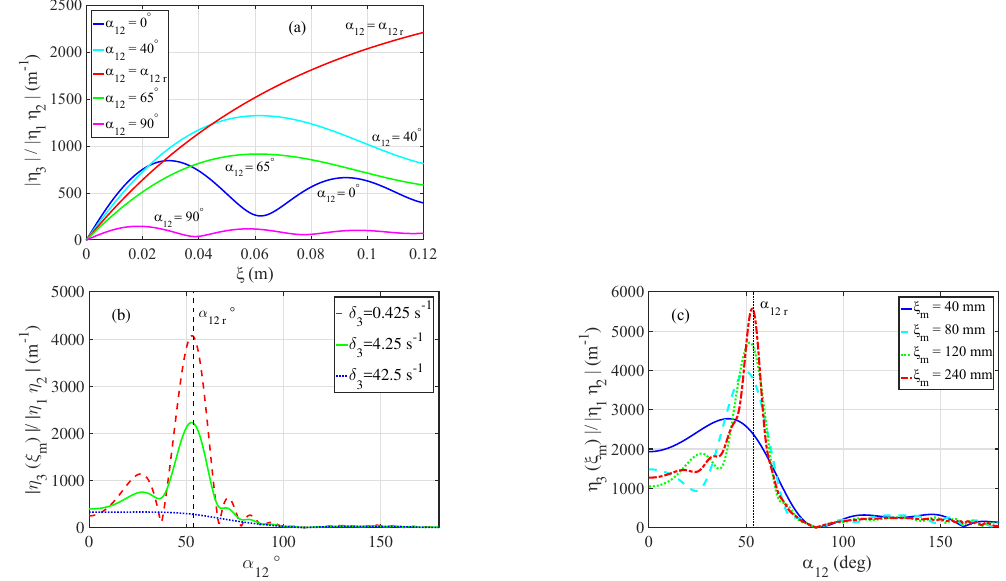
Figure 11. Prediction of the model of a forced three-wave interaction according to Cazaubiel et al. [42]. ( a ) Normalized amplitude | η 3 ( ξ ) / | η 1 η 2 | as a function of ξ , for various values of the angle α 12 between the two mother waves. ( b ) Normalized amplitude | η 3 ( ξ m ) | / | η 1 η 2 | evaluated in ξ m = 0.12m as a function of α 12 for various values of the dissipation rate ( δ 3 = 4.25s − 1 is the expected dissipation at f 3 = 33Hz in the experiments). The curve for negative values of α 12 is symmetric to the displayed one, due to the parity of the interaction coefficients with α 12 . ( c ) Amplitude of the daughter wave | η ( ξ m ) | (normalized by | η | ) as a function of α 3 1 η 2 12 for various values of the propagation distance ξ m for a dissipation rate δ 3 = 4.25s − 1 . (Reprinted with permission from Ref. [42] Copyright 2022 American Physical Society).